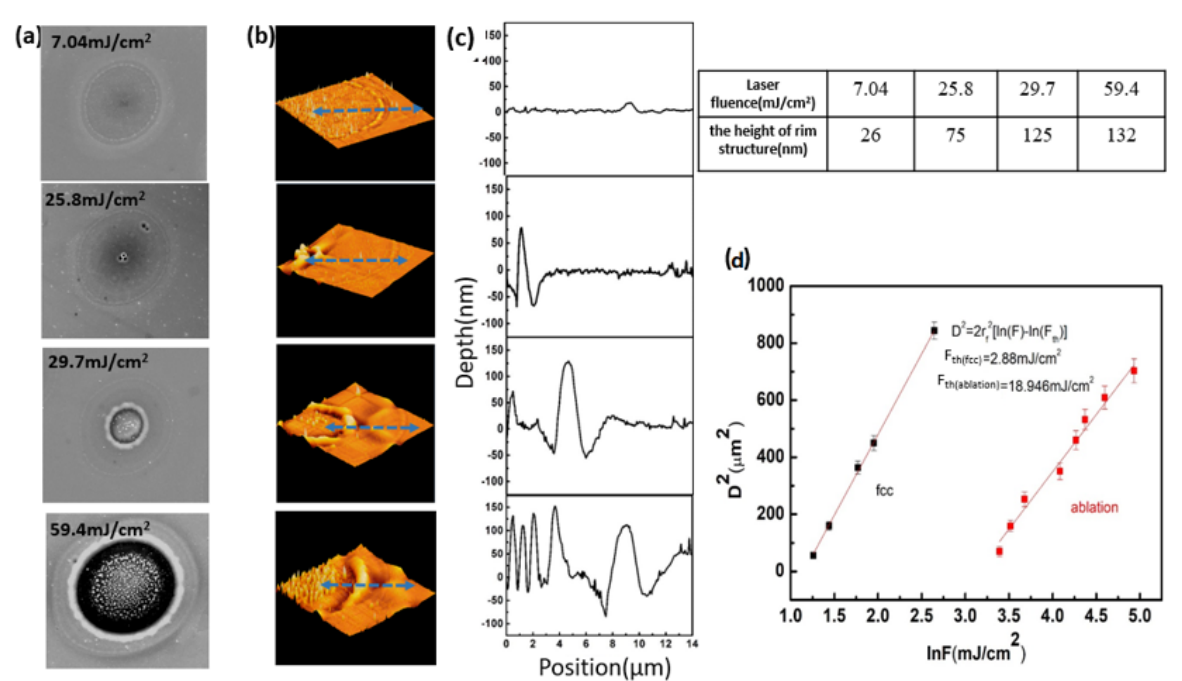
Figure 2. ( a ) Scanning electron microscopy; ( b ) AFM images; ( c ) the cross-sections AFM images; ( d ) Scheme 2. with a different degrees of phase change versus natural logarithm of the pulse fluence ln ( F ) .